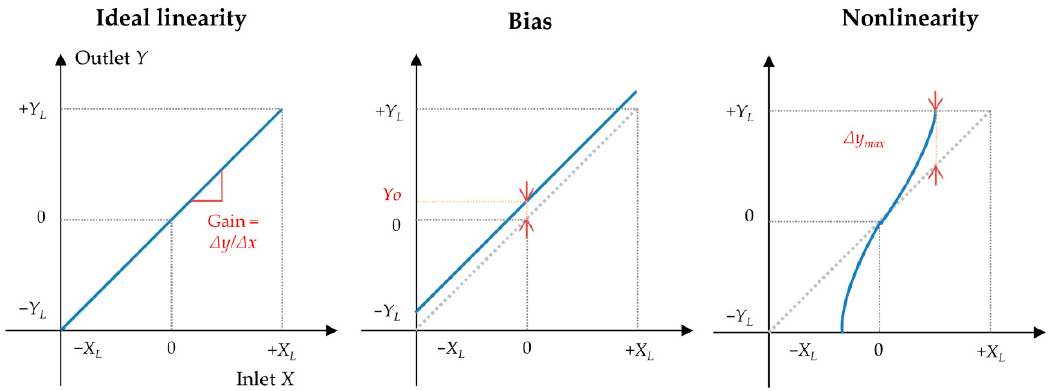
Figure 7. Ideal linearity, Bias and non-linearity sensor representation.